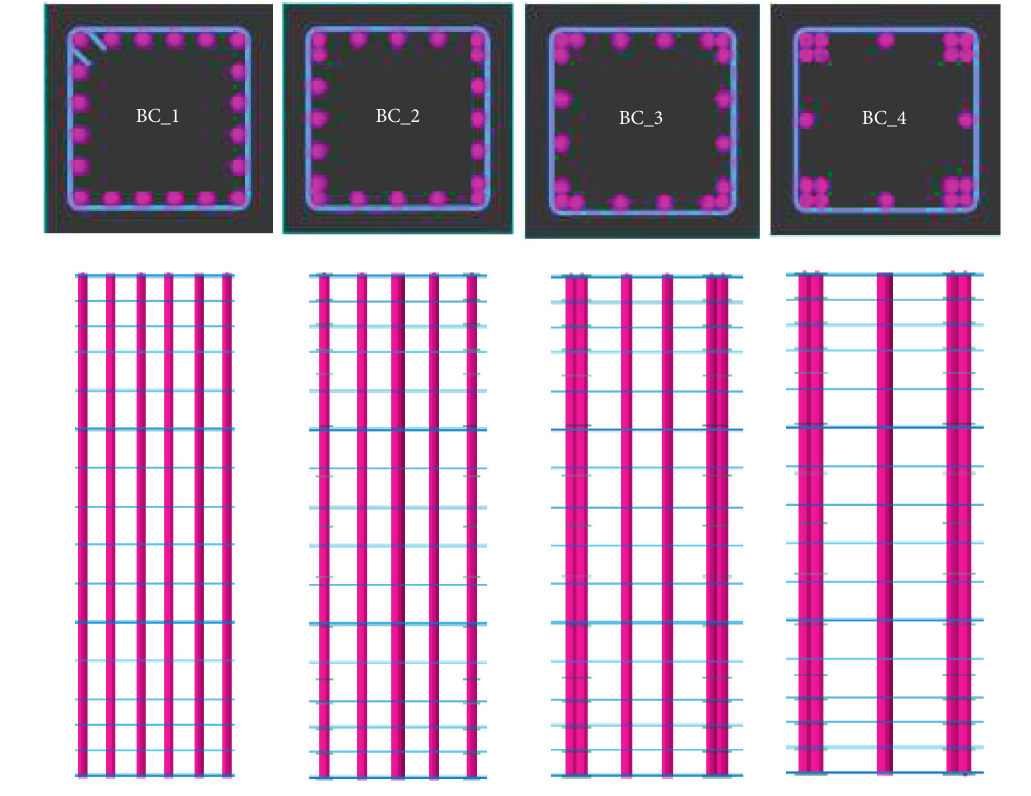
Figure 1: Cross-sectional and longitudinal BRC column specimen detailing. Table 1: Material properties for concrete and steel reinforcement. Concrete